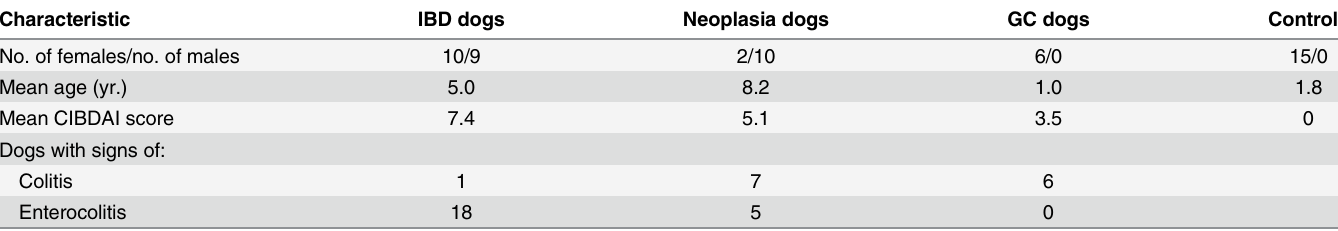
Table 3. Clinical characteristics of dogs studied. CIBDAI = canine IBD activity index with score reported at diagnosis. Characteristic IBD dogs Neoplasia dogs GC dogs Controls No. of females/no. of males 10/9 2/10 6/0 15/0 Mean age (yr.) Dogs with signs of: Colitis